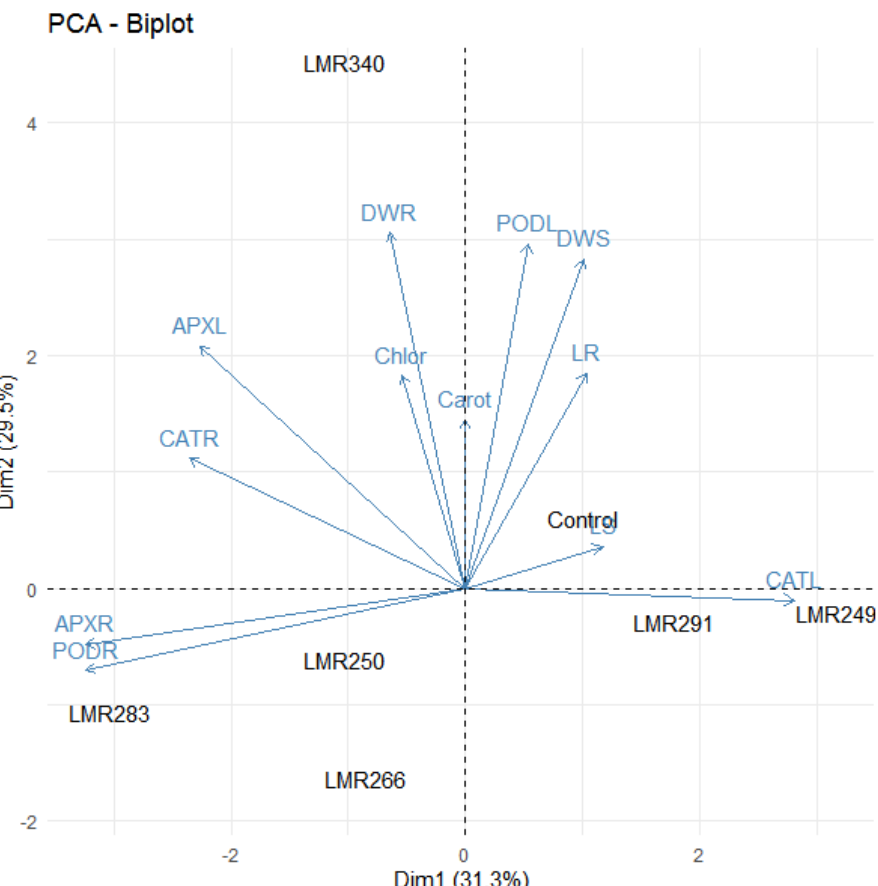
Figure 4. The correlation biplot between the Dim1 and Dim2 showed the 60.8% variation in which Dim 2 contributed 29.5% and Dim 1 contributed 31.3%. Strongly and positively correlated variables were very close to each other and present in the same quadrat. The blue color showed correlation between parameters (LS, LR, DWS, DWR, Chlor, Carot, PODL, PODR, APXL, APXR, CATL, CATR) while the black color showed correlation within treatments (Control, LMR249, LMR250, LMR266, LMR283, LMR291, LMR340).LS: Length of shoots, LR: Length of roots, DWS: Dry weight of